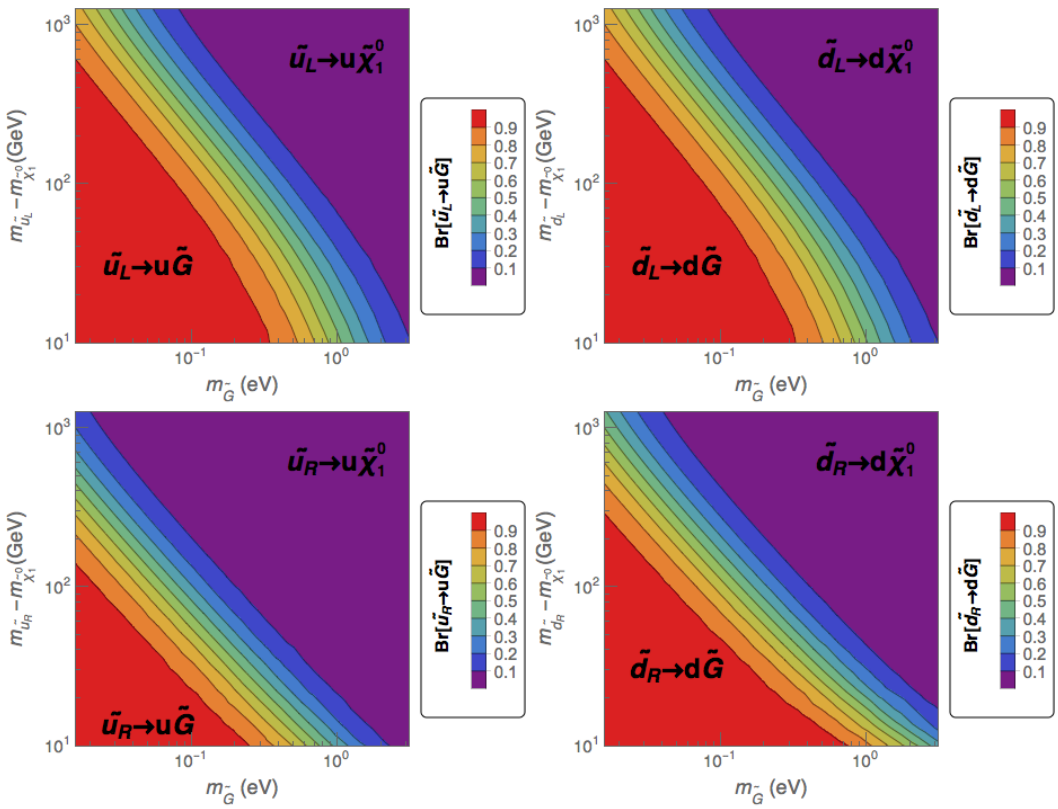
Figure 2 . Variation of BR( plots on the left show the distributions corresponding to the up-squarks and the plots on the right show the same for the